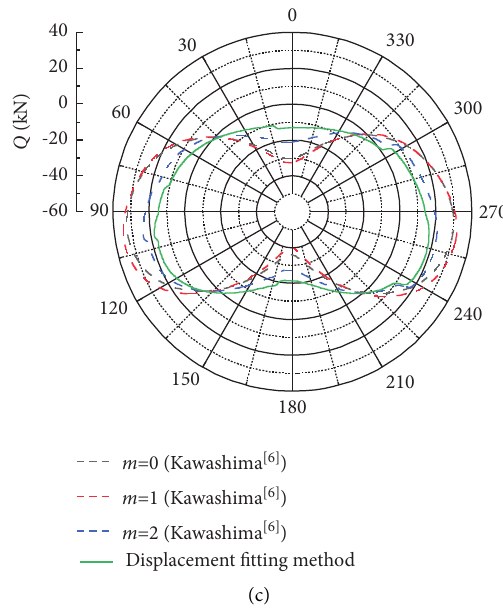
Figure 12: Results of internal forces. (a) Bending moment M ; (b) axial force N ; (c) shear force Q .